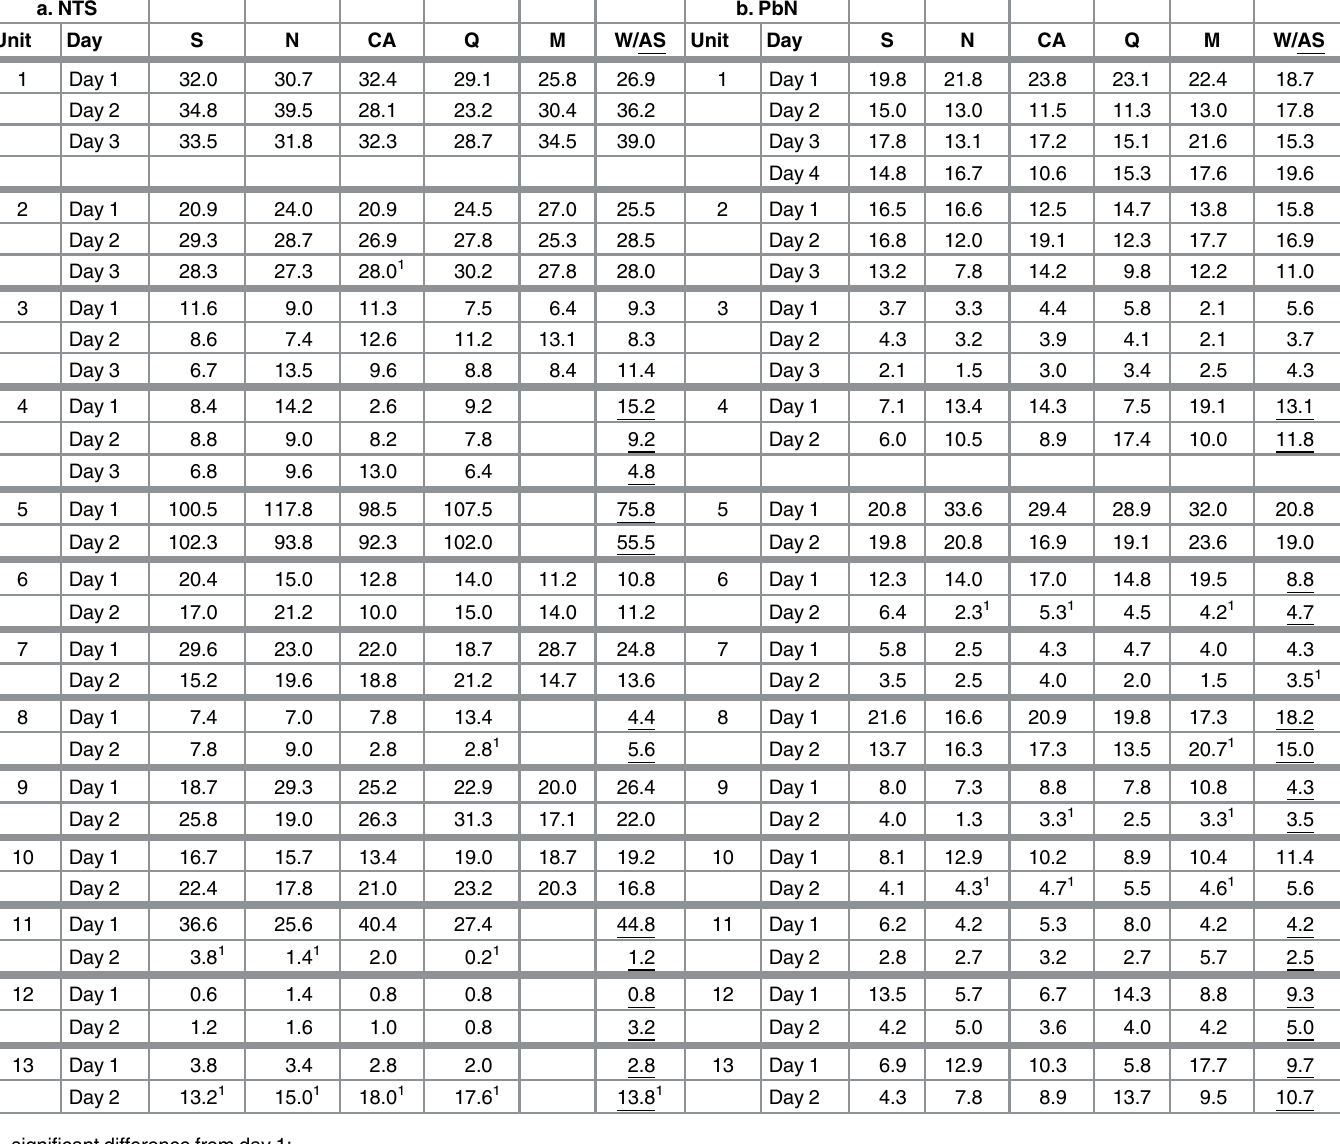
Table 3. Pre-stimulus baseline firing rates in spikes per sec (sps) in the NTS and PbN for taste stimuli of multiday recordings that met the “ same unit ” criterion. a.